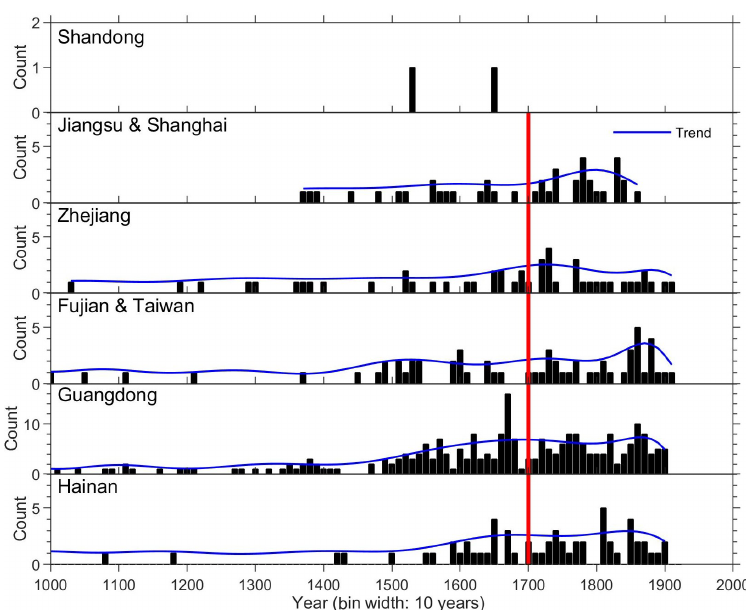
Figure 6. The number of typhoons that struck the southeastern regions of China and Taiwan between 1000 and 1910CE. (Red line means the time boundary of 1700CE. More TCs made landfall in Guandong before this time, but more TCs made landfall to northward after this time.)